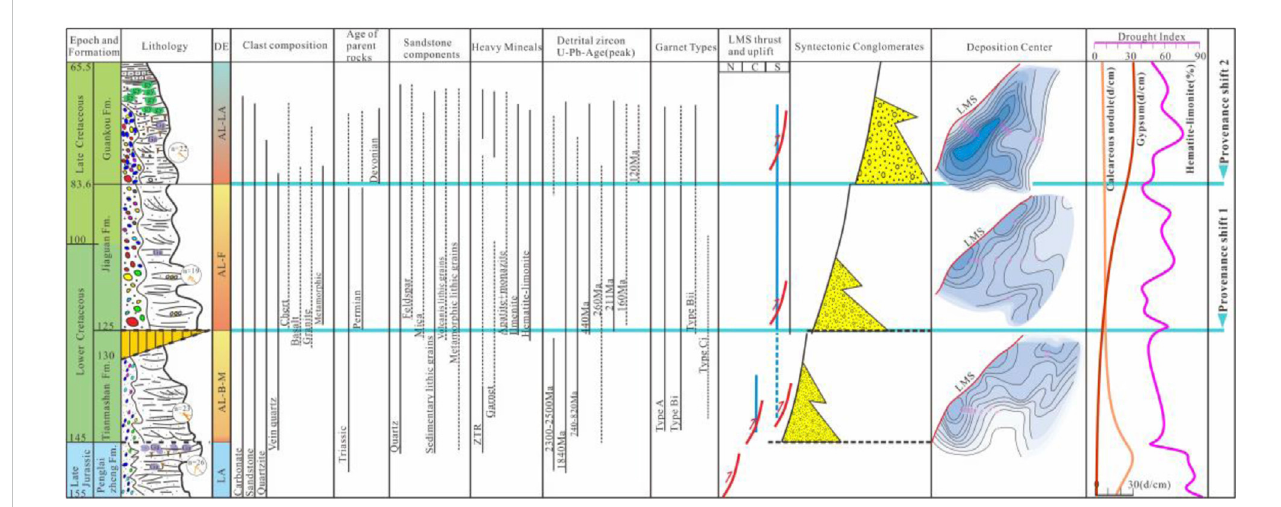
FIGURE 14 Generalized geological correlation between tectonic events (history of thrust and uplift, Longman Shan thrust belt in Longmanshan orogen), sedimentary events (depositional environment, paleocurrents, clast composition, stratigraphy, and depocenter) in the southwest corner of Cretaceous SichuanBasin.Dataforthehistoryofthethrustandupliftweremodi fi edfromLiuetal.(2018).Paleocurrentdata,clastcompositions,andparentrocksagedata fromtheCretaceousstrataweremodi fi edfromSBGMR(1993),LiandJi(1993),Gou(2001),andthisstudy.Dataforthestratigraphyanddepocenterwere modi fi ed from SBGMR (1993). Indicators of climate change (gypsum and calcareous nodule) come from fi eld observations and measurements. Hematite – limonite data are based on our heavy mineral analysis. DE. depositional environment; LA. lacustrine; AL-B-M. Alluvial fan, braided river, and meandering river; AL-F. Alluvial fan and fl uvial; AL-LA. Alluvial fan and